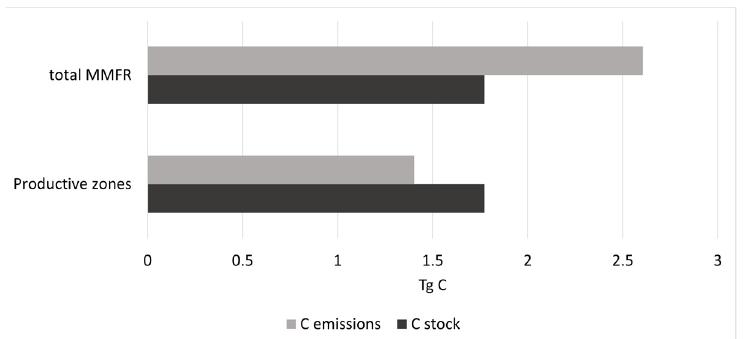
Figure 5. Comparison of AGB carbon stock and emissions from both pole and charcoal production for the productive forest zones and the total MMFR.